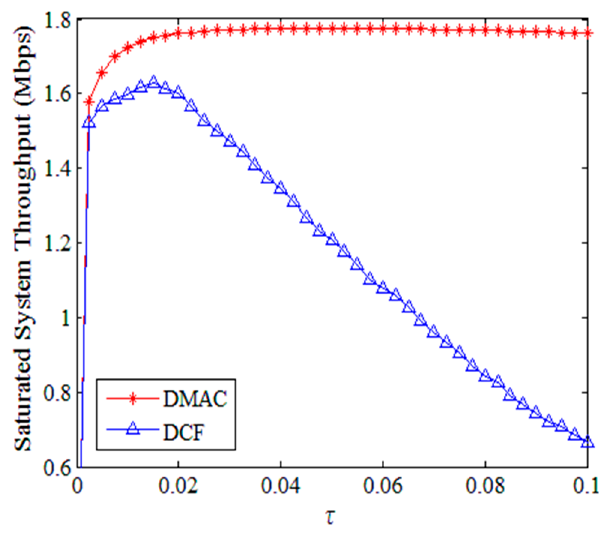
Figure 3. Saturated system throughput versus τ .